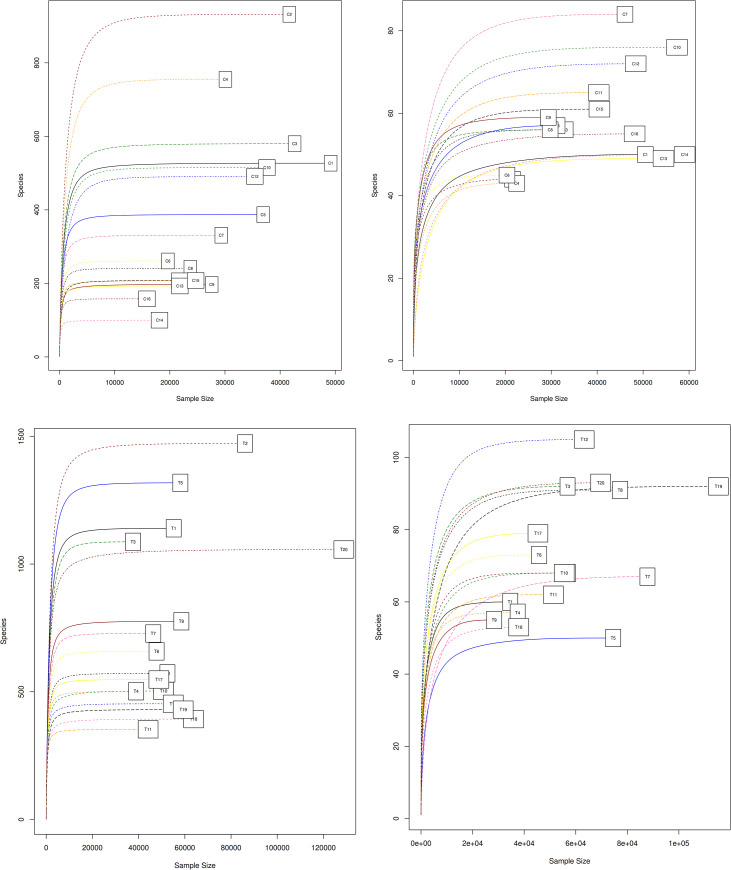
a-d. Rarefaction curves indicating level of sequence coverage.